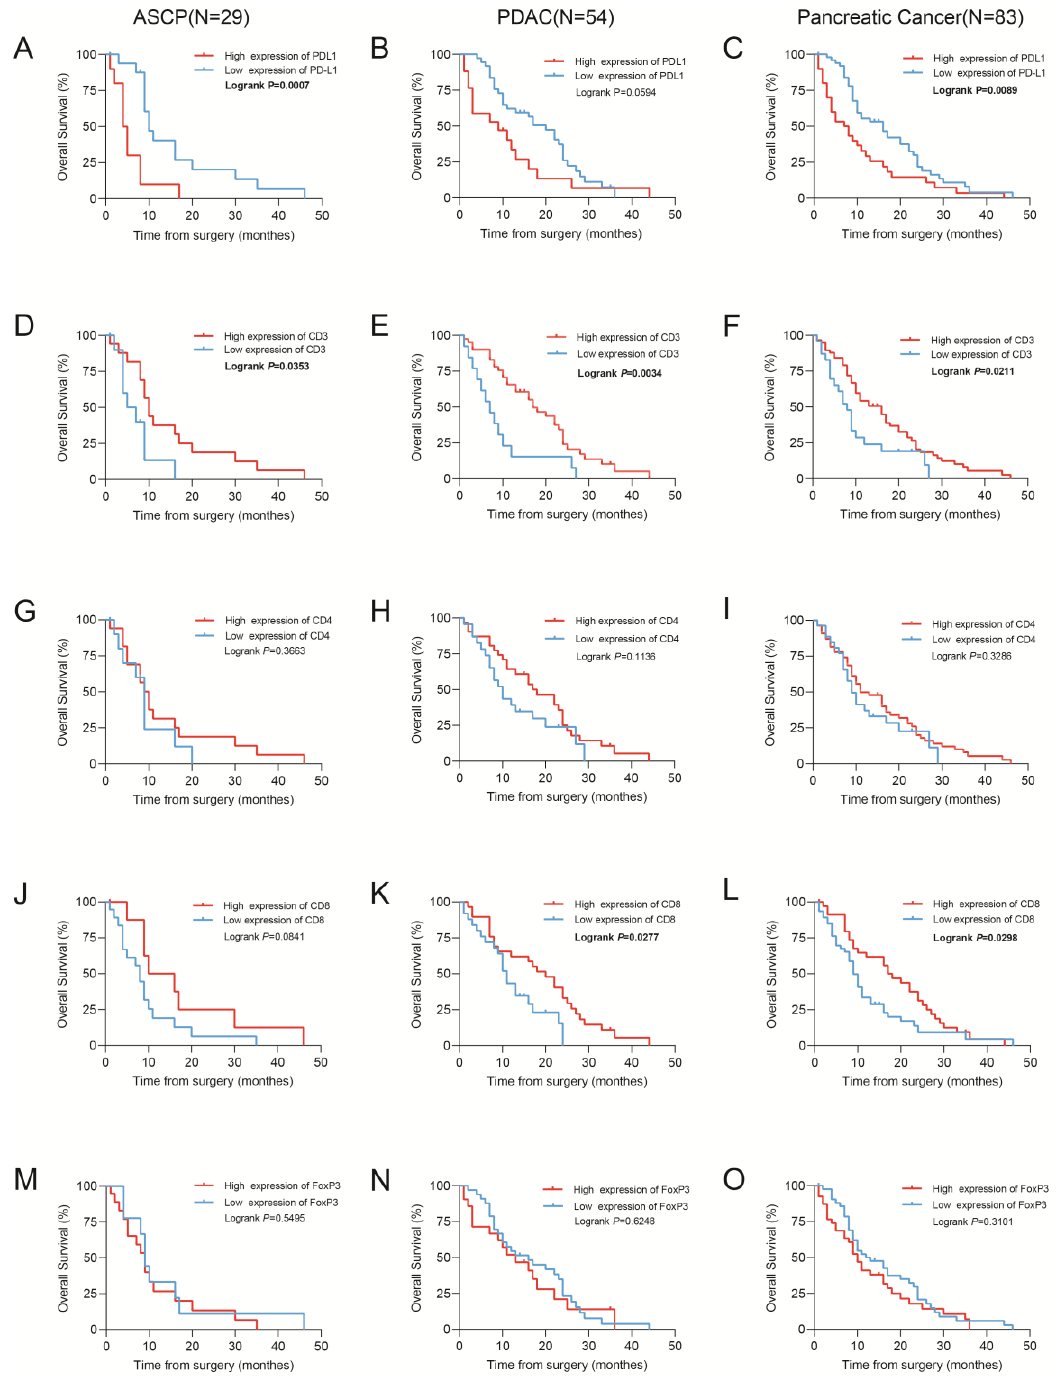
Figure 2. Kaplan–Meier estimates of overall survival. ( A – E ) Kaplan–Meier curves for overall survival according to the PD-L1, CD3, CD4, CD8, and FoxP3 immunoscores in cohorts of patients with adenosquamous carcinoma of the pancreas (ASCP). ( F – J ) Kaplan–Meier curves for overall survival according to the PD-L1, CD3, CD4, CD8, and FoxP3 immunoscores in cohorts of patients with pancreatic adenocarcinoma (PDAC). ( K – O ) Kaplan–Meier curves for overall survival according to the PD-L1, CD3, CD4, CD8, and FoxP3 immunoscores in cohorts of patients with pancreatic cancer. A total of 83 patients (29 ASCP patients and 54 PDAC patients) were included in the pancreatic cancer group.